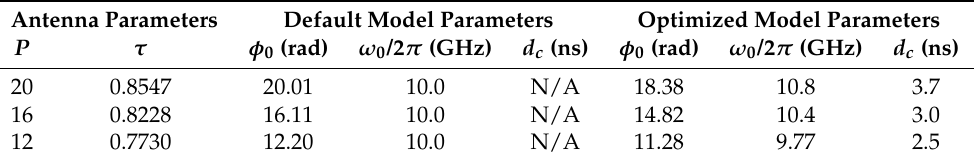
Table 1. Log-periodic dispersion model parameters from Equation (6) and optimized versions for the three different sinuous antennas